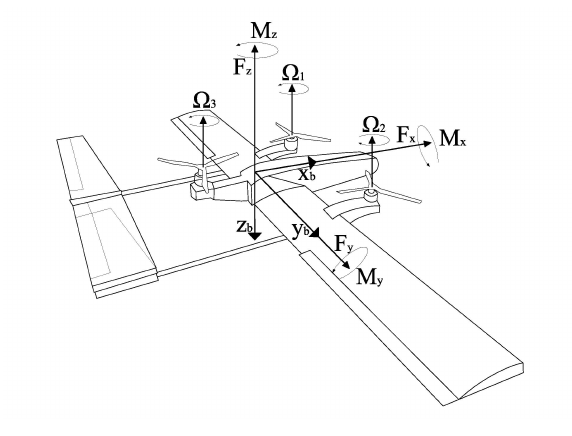
Fig. 1. Structural diagram of tilt three-rotor